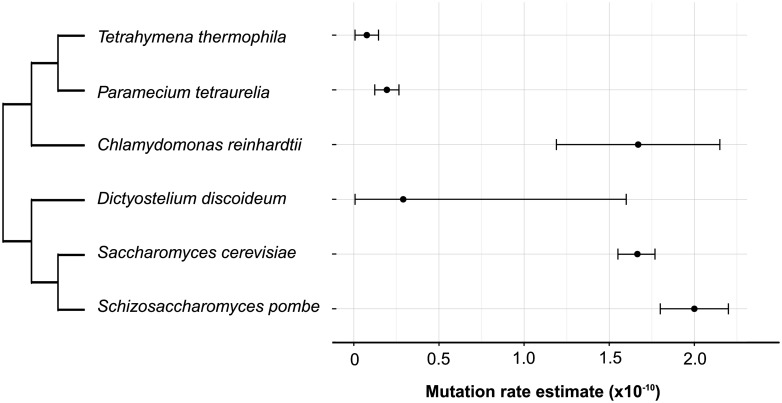
Mutation rate estimates for unicellular eukaryotes. Base-substitution mutation rates per nucleotide per generation estimated for different unicellular eukaryotes: T. thermophila (this paper), P. tetraurelia (Sung, Tucker, et al. 2012), C. reinhardtii (Ness et al. 2015), D. discoideum (Saxer et al. 2012), Sa. cerevisiae (Zhu et al. 2014), and Sc. pombe (Farlow et al. 2015). The phylogenetic tree was retrieved from the Open Tree of Life (Hinchliff et al. 2015); branch lengths are arbitrary. Error bars are 95% confidence intervals (ignoring uncertainty in the number of sites at which a mutation could be detected and the number of generations for which each MA experiment ran).